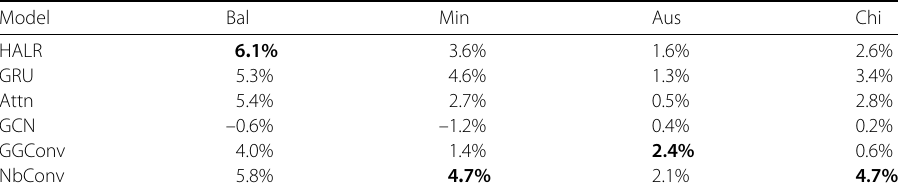
Table 8 Average relative change in F1 score using C + M for property crimes over all test months (Aug-Dec) in each city